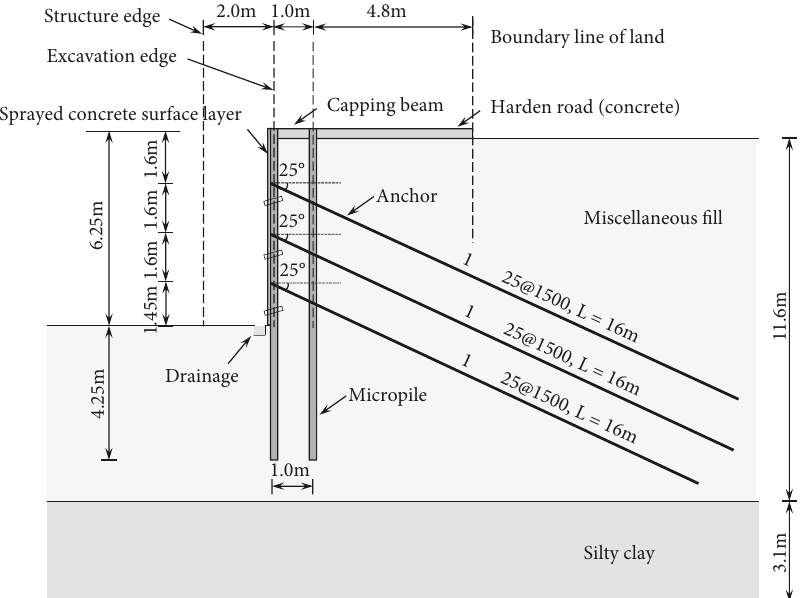
Figure 2: Typical section of double row steel pipe micropile composite retaining